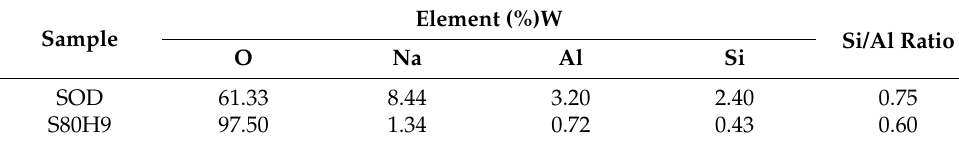
Table 5. Elemental composition of sample.